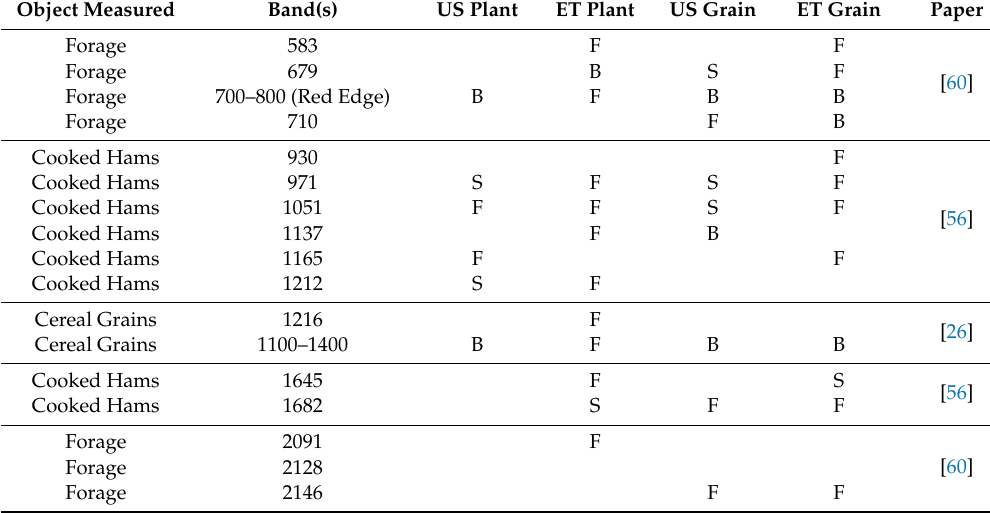
Table 8. Identification of matching bands associated with tef protein content that has also been identified as important protein indicators in past hyperspectral studies. Abbreviations: S: Savitsky–Golay; F: